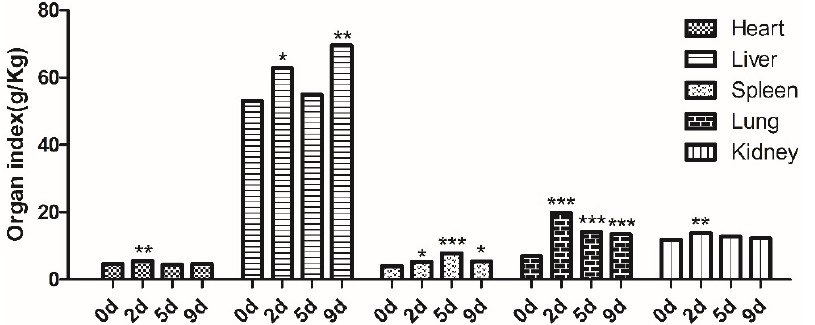
Figure 3. The organ index of heart, liver, spleen, lung, and kidney from mice (n = 8) on days 2, 5, and 9 after infection; i.v. infected with M. gypseum (4 × 10 6 CFU/mL). The results are presented as mean ± SD and represent three individual experiments (n = 8 mice per group). * p < 0.05; ** p < 0.01; *** p < 0.001.